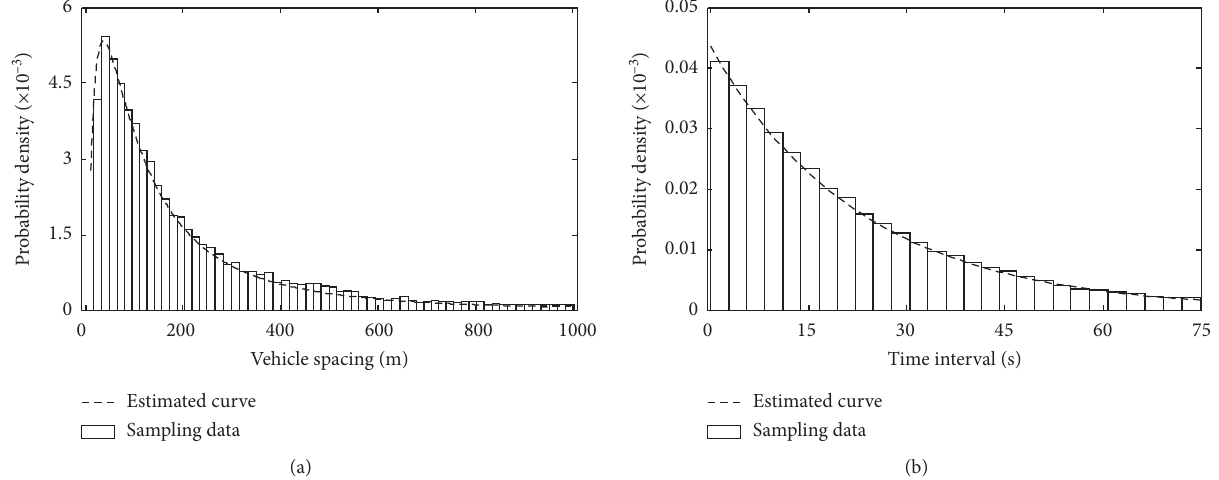
Figure 6: The sampling results of s and t : (a) random variable s and (b) random variable t .